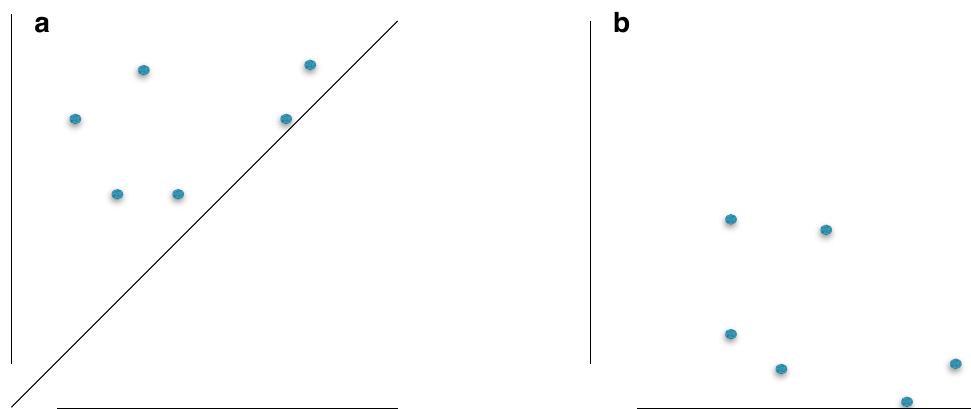
Figure 2. Persistence diagram transformation. Each point ( a i , b i ) on the persistence diagram on ( a ) is projected onto Euclidean plane ( b ) via ( a i , b i − a i )